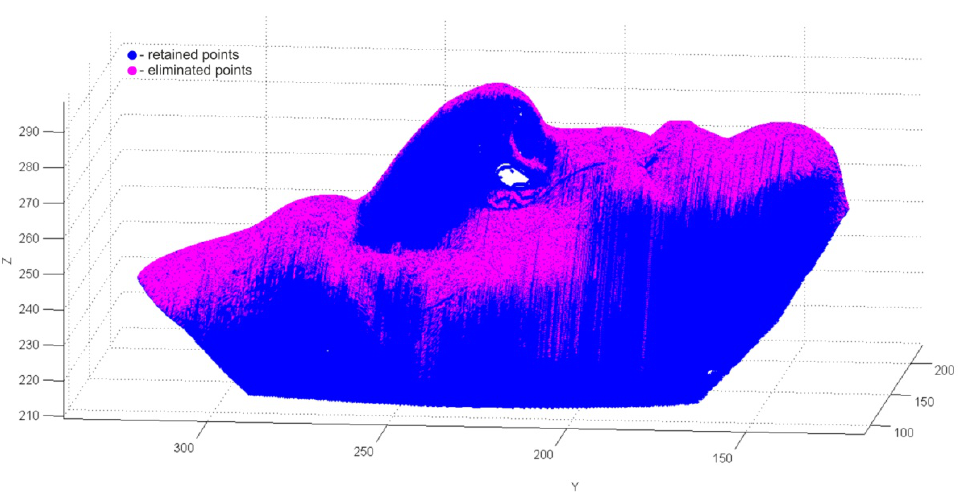
Figure 17. The result of point data reduction.